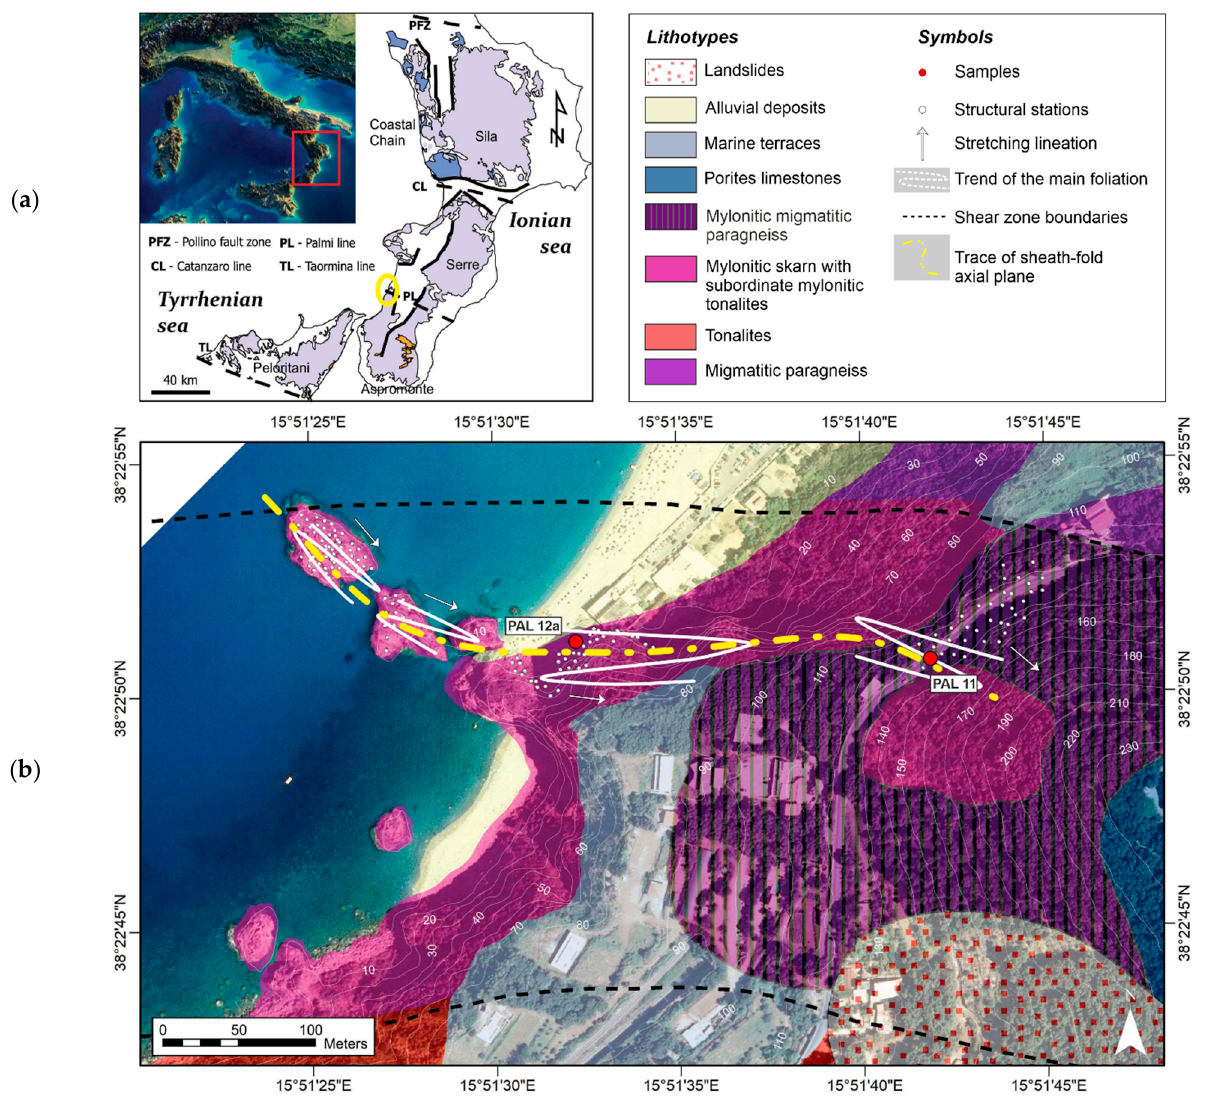
Figure 12. Geological background of the Palmi Shear Zone: ( a ) Geological map of the Calabrian metamorphic complexes (after Angì et al. [46]); ( b ) Geological Map of the case study area of the Palmi Shear zone with trends of the main foliations and average stretching lineations, (white circles represent location of each structural station, while red circles represent sample locations).